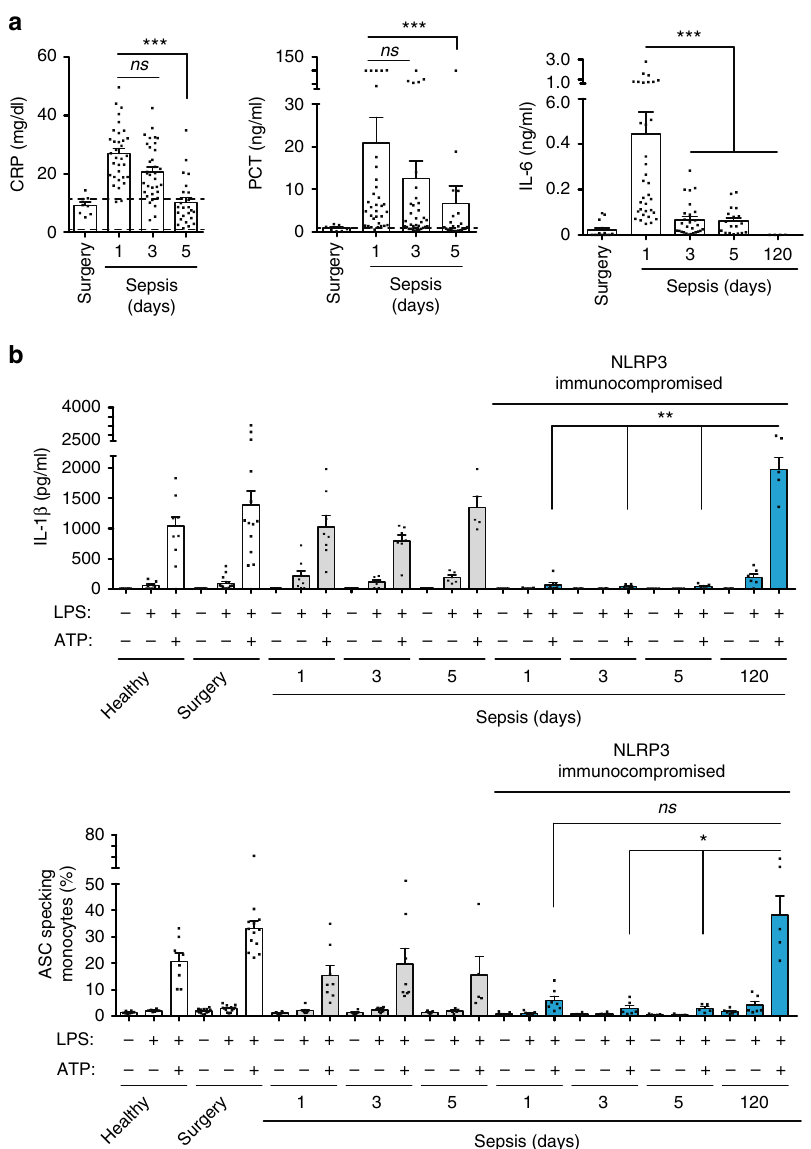
Fig. 3 NLRP3 immunoparalysis during sepsis is transitory. a Concentrations of C-reactive protein (CRP), procalcitonin (PCT), and IL-6 in plasma of septic patients at days 1, 3, and 5 during sepsis and at day 120 after sepsis recovery; dotted lines represent normal concentration of CRP and PCT. Levels of these markers in septic patients were compared with the abdominal surgery controls at 24 h after surgery. Control group and septic patients at day 1 correspond to patient data presented in Fig. 1a, b, and are shown here for comparison. b ELISA for IL-1 β in PBMC supernatants (top) and percentage of monocytes with intracellular ASC specks (bottom) after NLRP3 in fl ammasome activation by LPS (1 μ g/ml, 2 h) and ATP (3 mM, 30 min) treatment from control groups and NLRP3 non-immunocompromised (gray) or NLRP3 immunocompromised (blue) septic patients at day 1, 3, 5 during sepsis and at day 120 after sepsis recovery. Control groups and septic patients at day 1 correspond to patient data presented in Fig. 2a, b, and are shown here for comparison; each dot represents an individual patient; average ± standard error is represented in all panels; exact n number for each panel is presented in Source Data fi le; * p < 0.05; ** p < 0.01; *** p < 0.001; ns , no signi fi cant difference ( p > 0.05); Kruskal – Wallis test for a ,